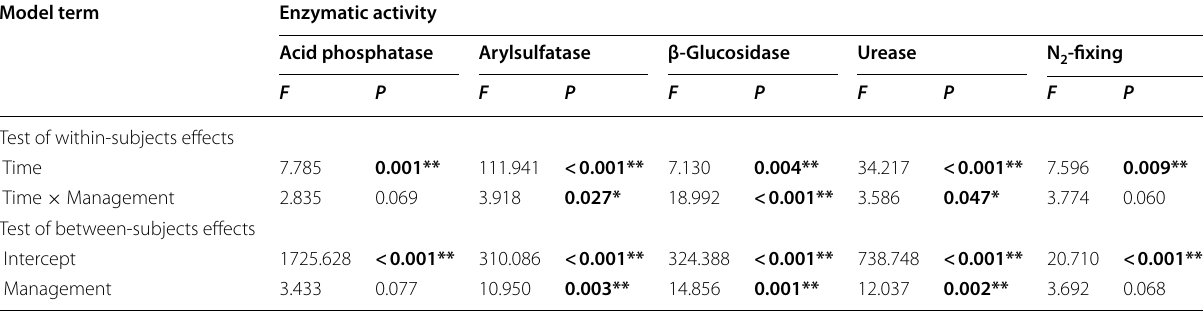
Significance is indicated by **p-value < 0.01, and *p-value <